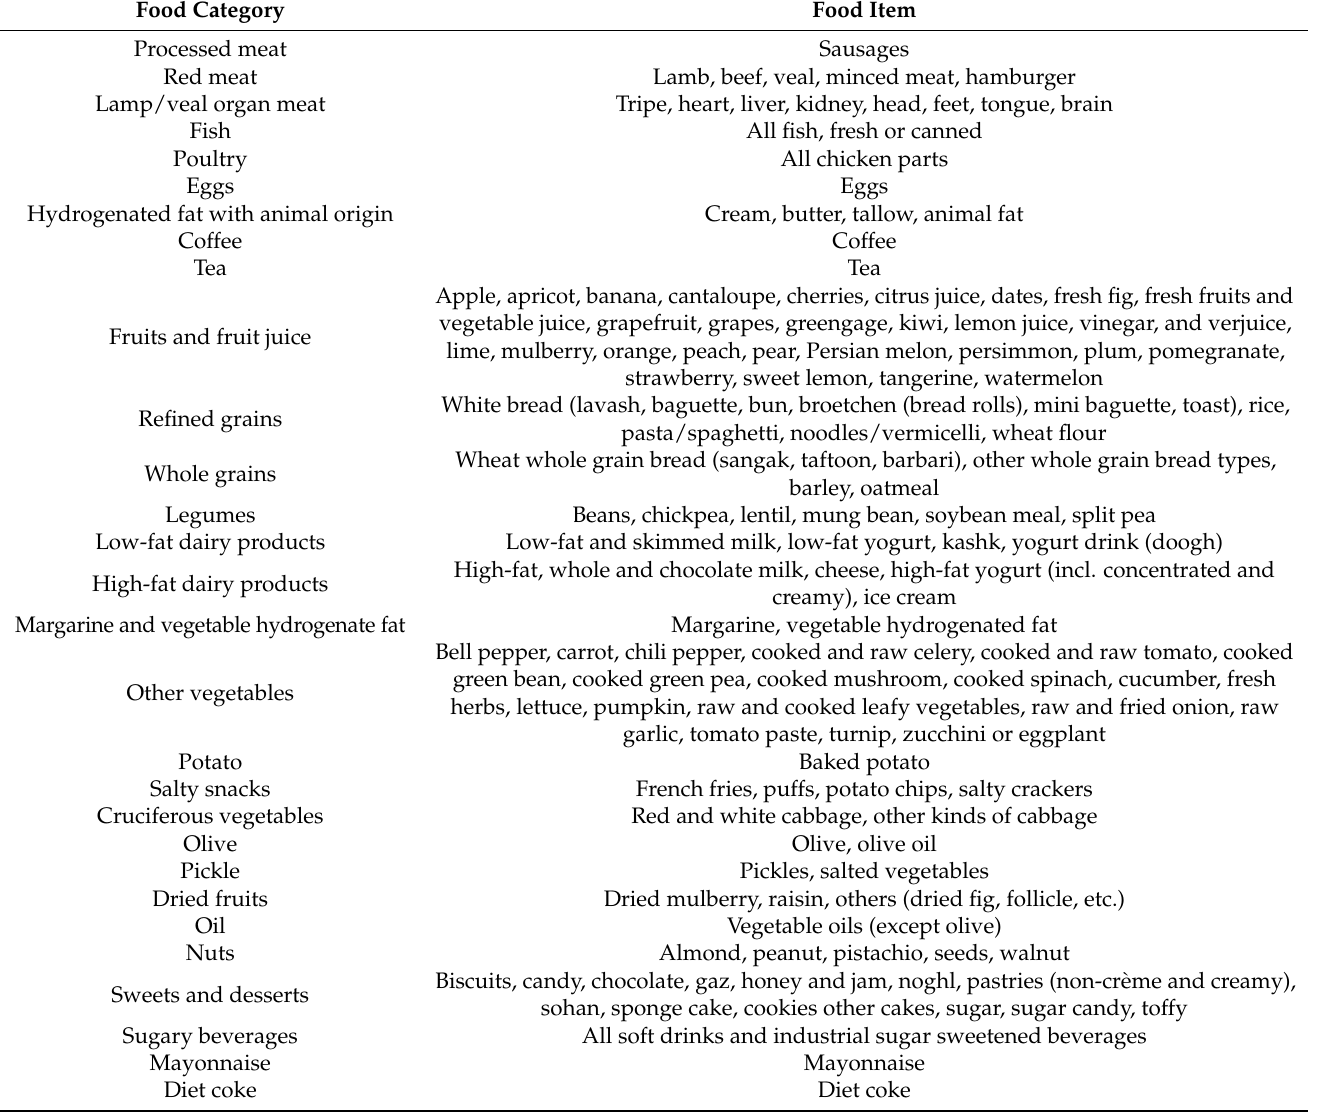
Table 1. Food grouping used in principle component analysis of the 168 food items in the food frequency questionnaire for the identification of dietary